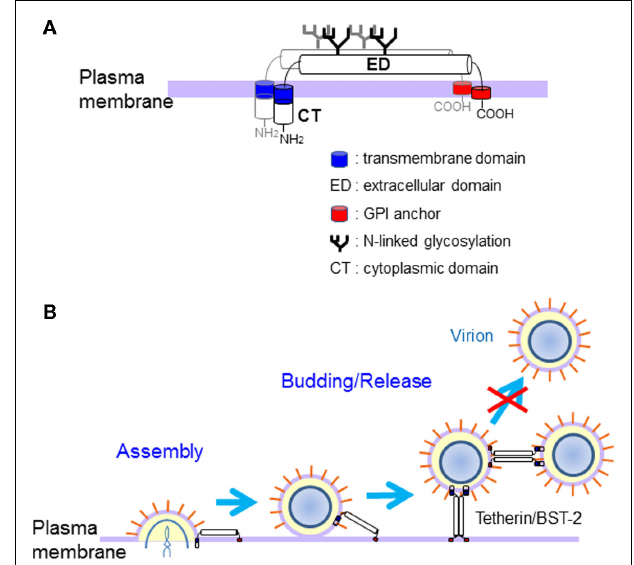
FIGURE 2 | Structure and antiviral action ofTetherin/BST-2. (A) Structural representation of tetherin/BST-2.Tetherin/BST-2 has two putative N-linked glycosylation sites in the extracellular domain and forms a homodimer by intermolecular disulfide bonds. Both ends of tetherin/BST-2 are associated with the plasma membrane via the N-terminal transmembrane domain and C-terminal GPI anchor. (B) Proposed model for the antiviral mechanism of tetherin/BST-2.Tetherin/BST-2 appears to inhibit the release of progeny viruses by directly tethering virions to cells, briefly by anchoring one end of the molecule on the cell membrane and the other end on the viral envelope. Progeny virions could be also directly tethered to each other by